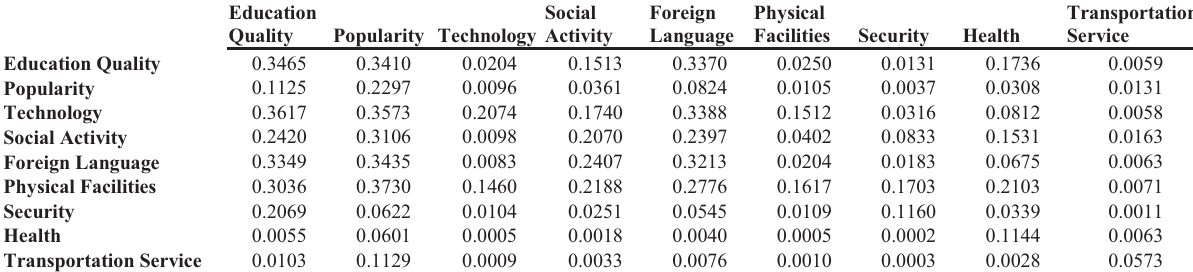
Table 4. Steady state matrix for f ( x )=